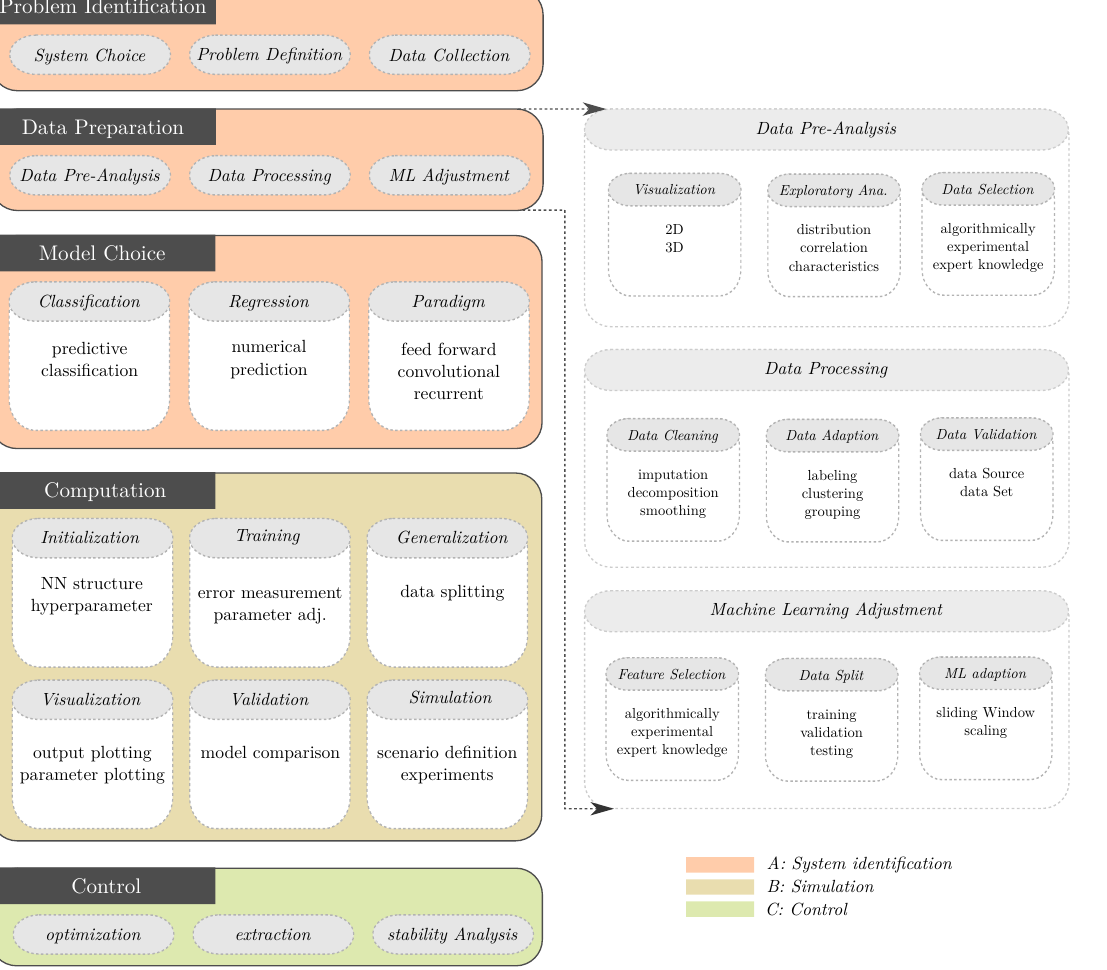
Figure 7. Overview of the modular framework for step-by-step system identification with